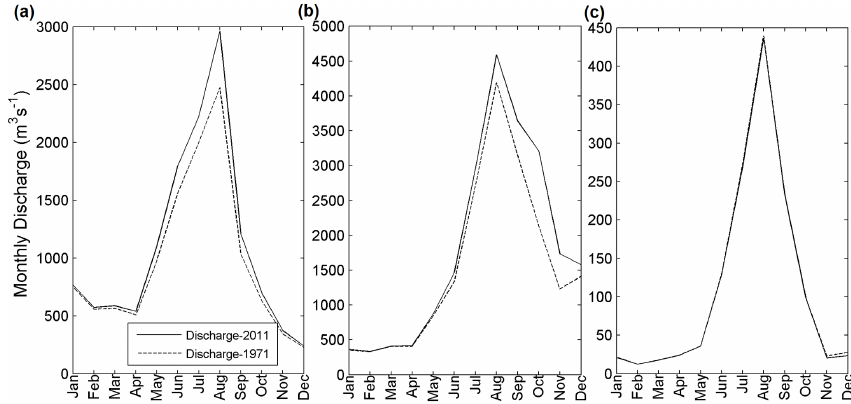
Figure 9. Simulation results for 1971 and 2011 for (a) upstream, (b) midstream and (c) downstream regions.